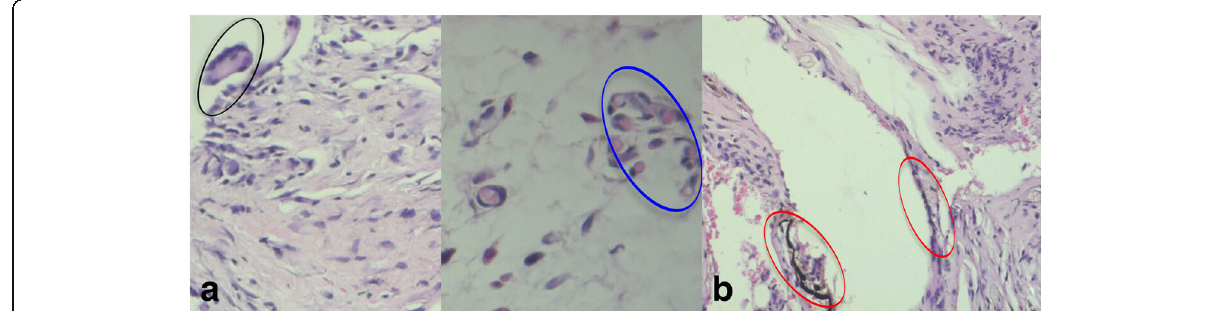
Fig. 6 a The sample of the control group at day 30, Giant cell ( black encircled ) (H&E; ×200), Eosinophil ( blue encircled ) (H&E, ×400). b The sample of the study group at day 30 , brown-black granules ( red encircled ) (H&E;